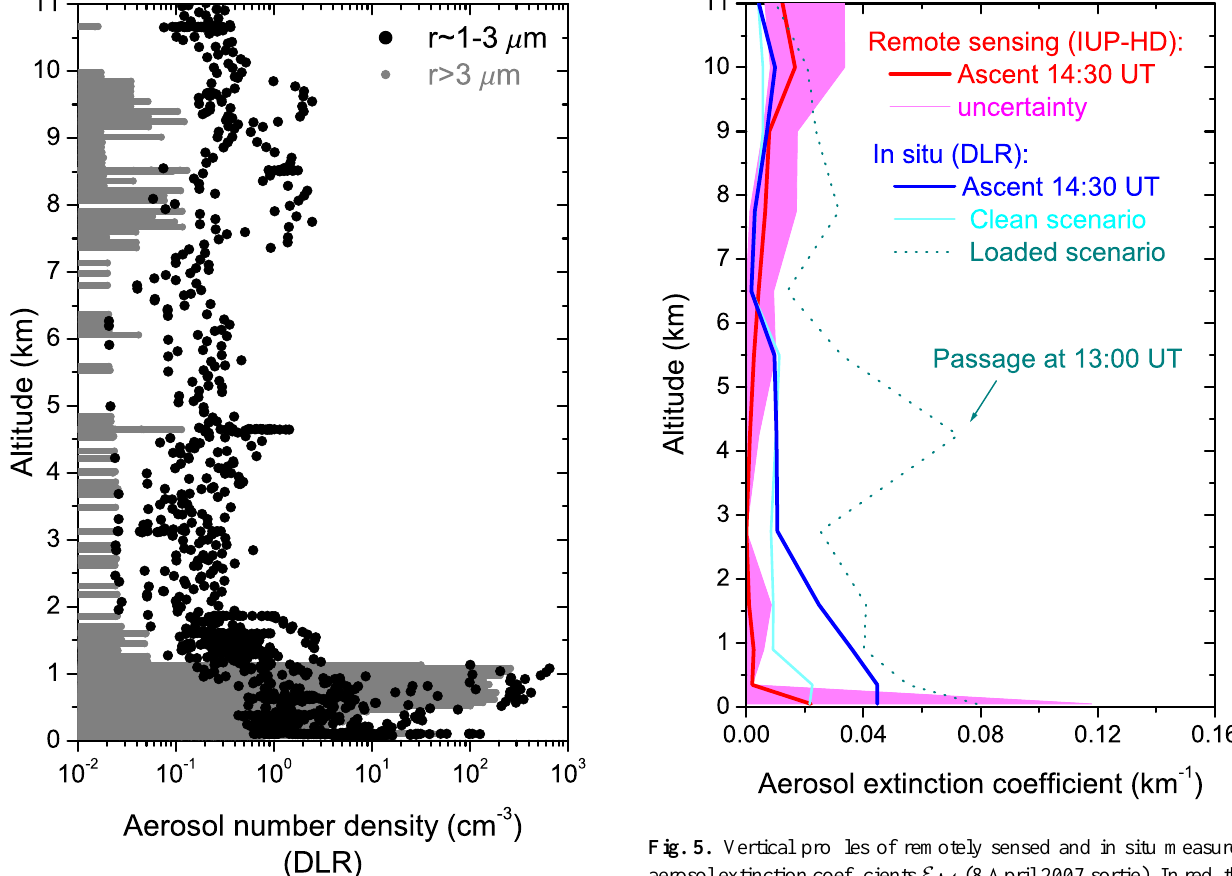
Fig. 5. Vertical profiles of remotely sensed and in situ measured aerosol extinction coefficients E M (8 April 2007 sortie). In red, the IUP-HD E M retrieved at 353nm from measurements performed during the ascent at 14:30UT is presented (79% ground albedo, g = 0.7). The pink shadow covers wavelength (349–360.8nm) and ground albedo uncertainties of IUP-HD E M . The profiles derived (at 349 nm) from the in situ data correspond to the ascent at 14:30 UT (dark blue), and to a clean (cyan) and aerosol loaded case scenario (dashed line) measured during the 8 April 2007 flight.